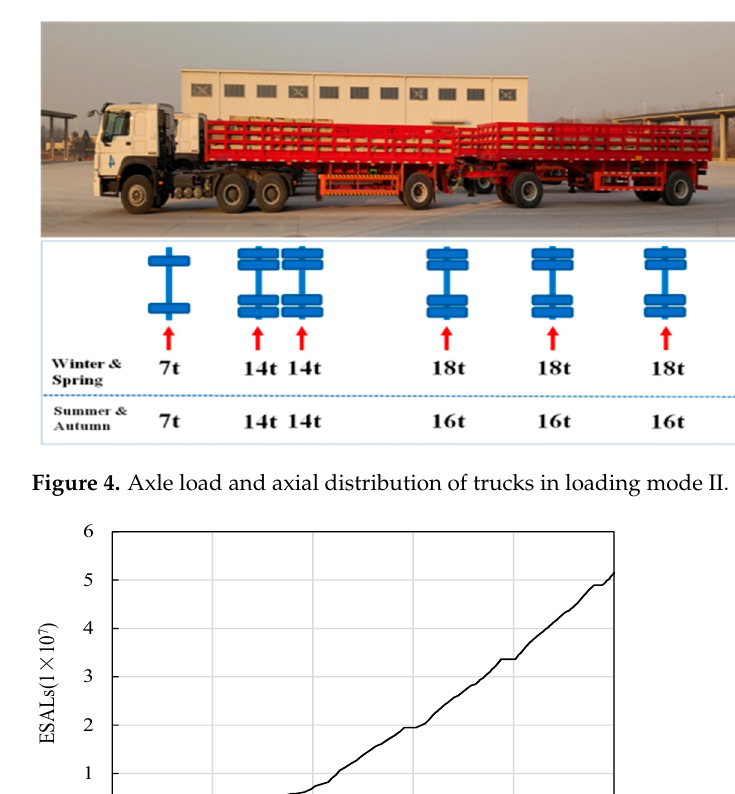
Figure 3. Axle load and axial distribution of trucks in loading mode I.